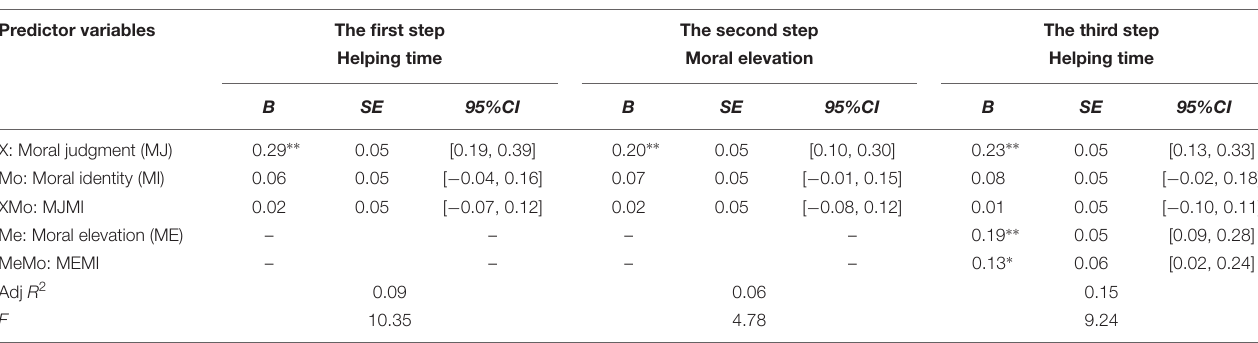
TABLE 3 | Least squares regression results for women. Predictor